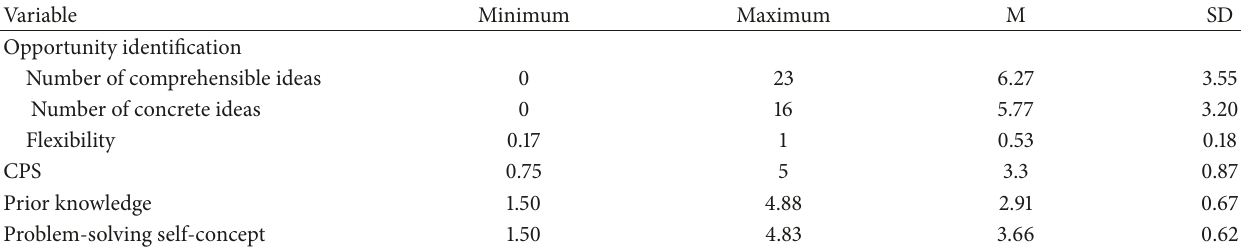
Table 1: Descriptive statistics for the assessment of OI, CPS, prior knowledge, and problem-solving self-concept.